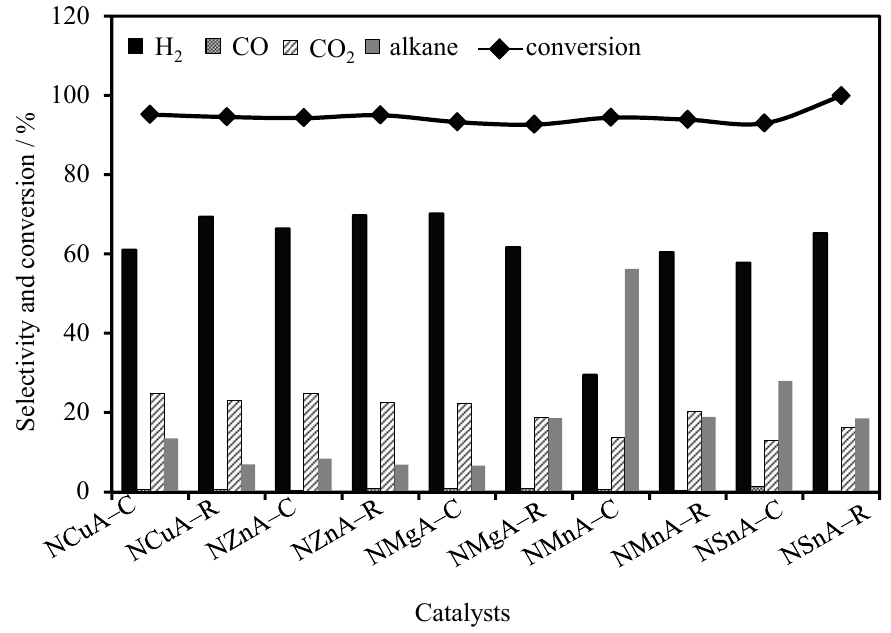
Figure 5. The selectivity of H 2 , CO, CO 2 , and alkane in the gas products after aqueous-phase reforming (APR) of ethylene glycol over hydrotalcite-derived catalysts.